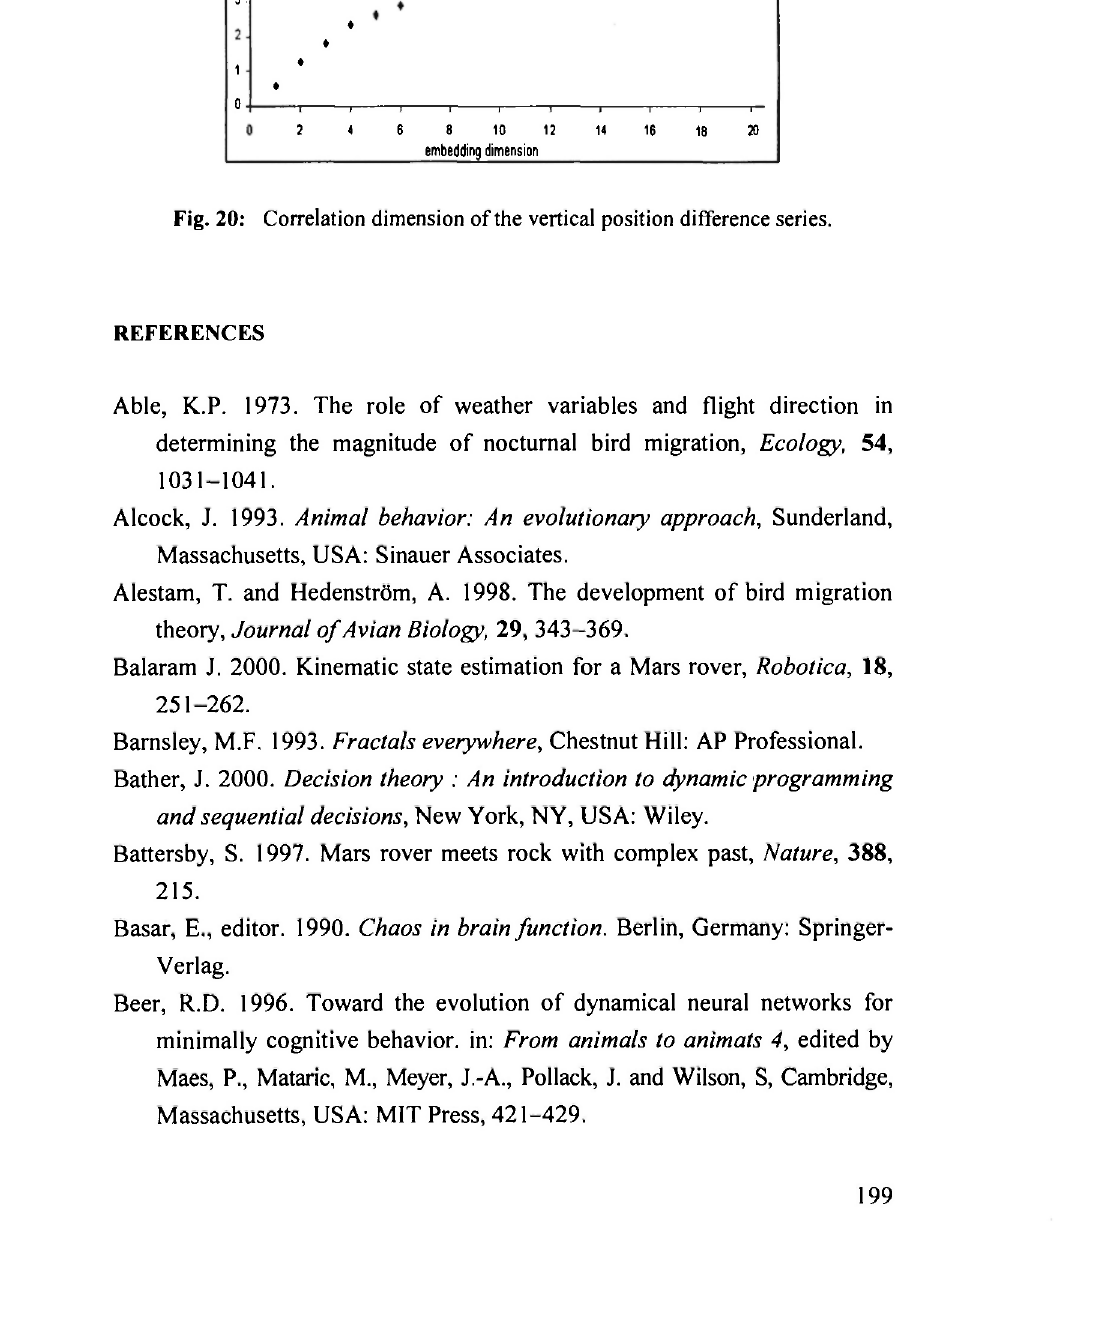
Fig. 20: Correlation dimension of the vertical position difference